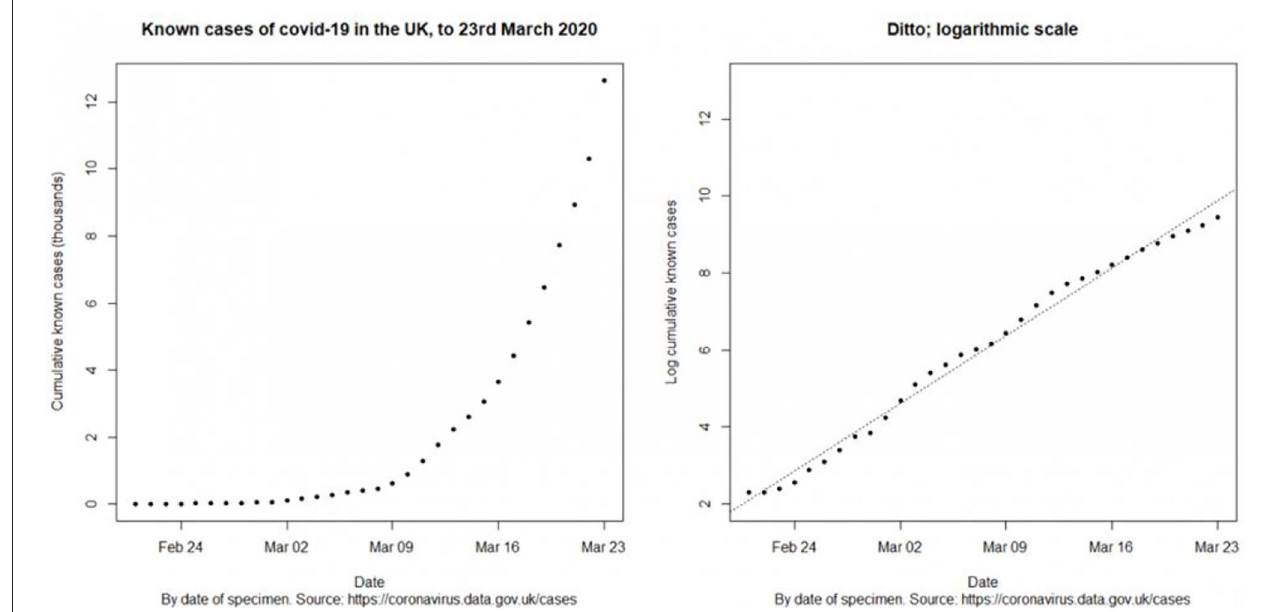
FIGURE 1 | The cumulative number of Covid-19 cases in the UK as a function of time in linear (left) and a log-log (right) representations (source: Stevens et al.